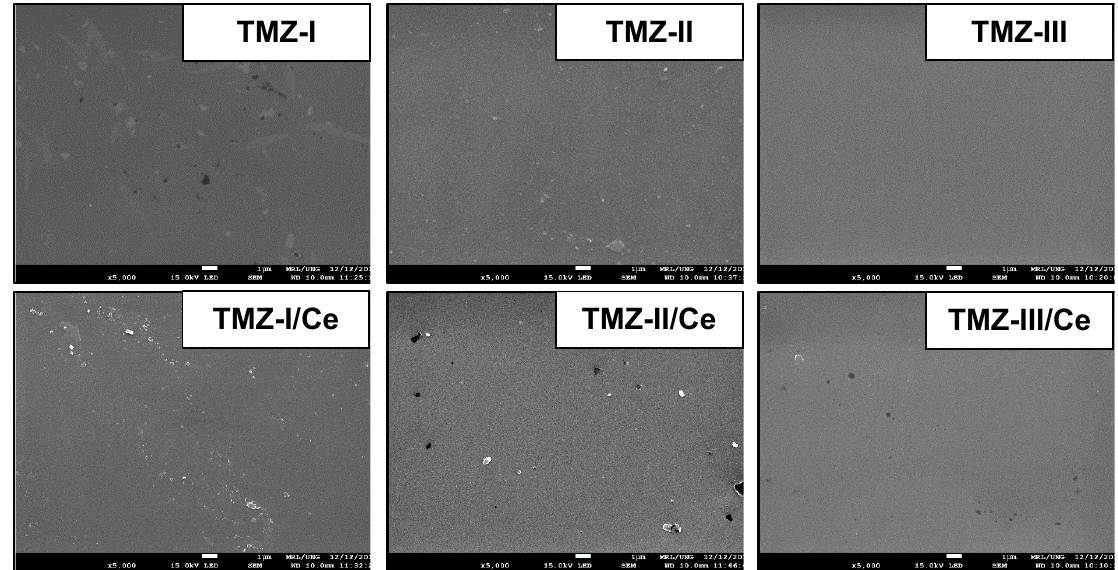
Figure 8. The SEM images (5000 × ) of the TMZ